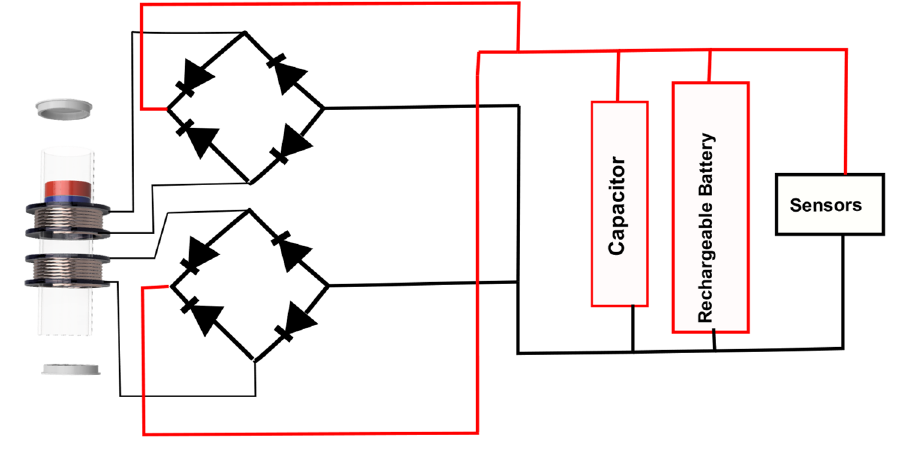
Figure 2. Functional diagram of the implemented energy harvesting system.